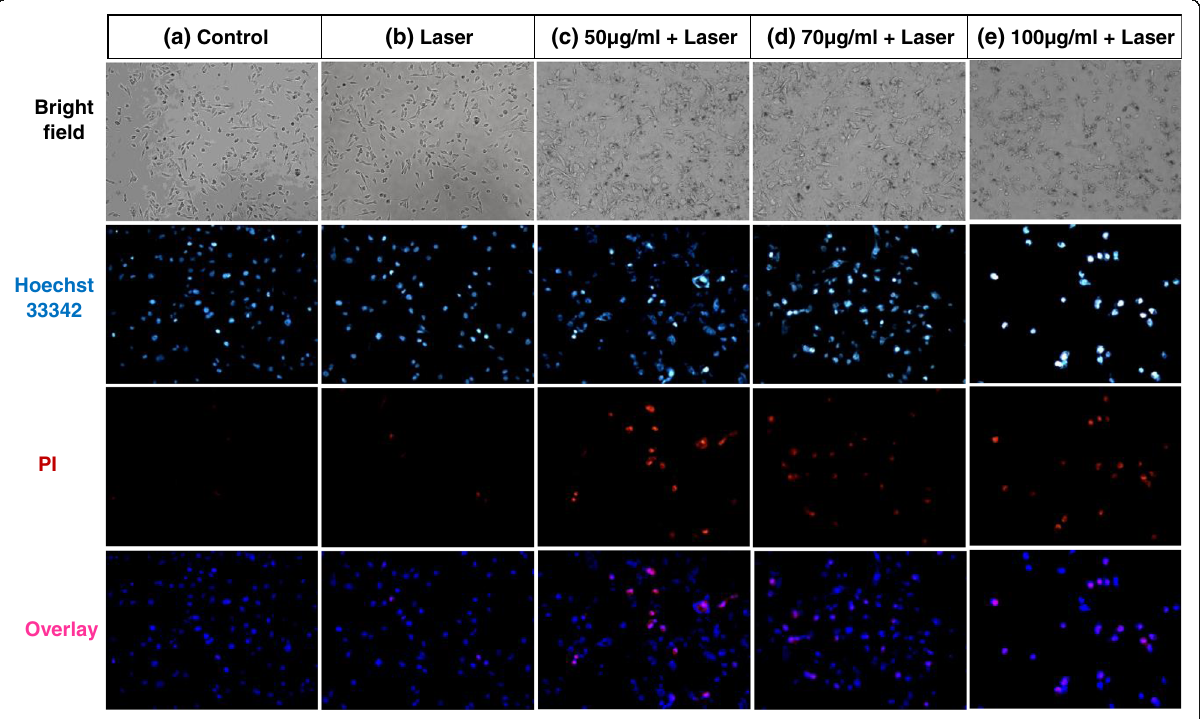
Fig. 9 Bright field and fluorescence images of MDA-MB-231 cells under different conditions. a Control. b Laser only. c 50- μ g/mL